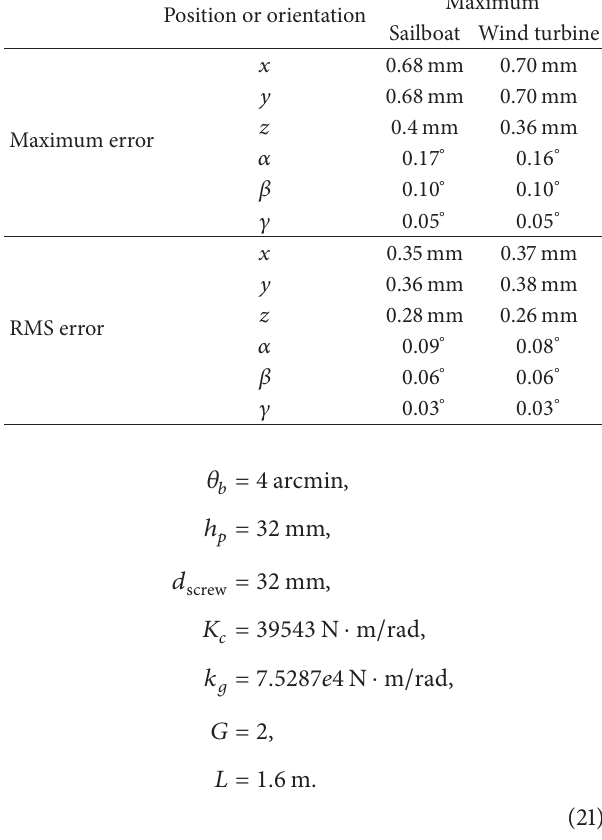
Table 3: Values of the maximum error and RMS of error in the desired robot